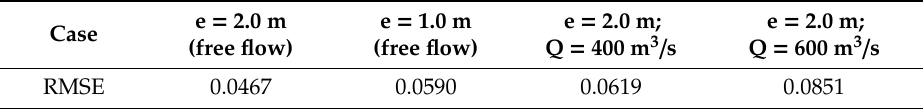
Table 3. RMSE calculated for the flume experiments.